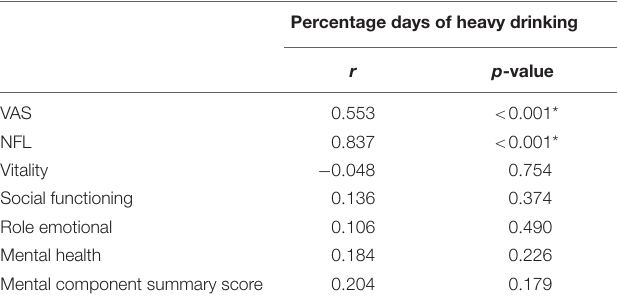
Statistics in the table represent the correlation between the difference values of each indicator before and after treatment. VAS, visual analog scale; NFL, neurofilament light chain. *p <